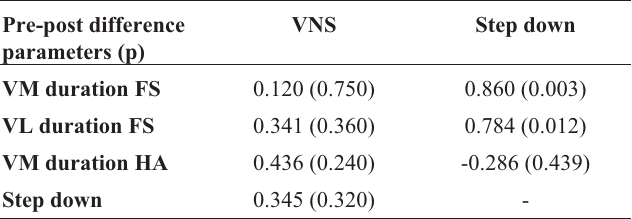
Table 5 - Correlation and p values of the pre-post difference EMG and clinical